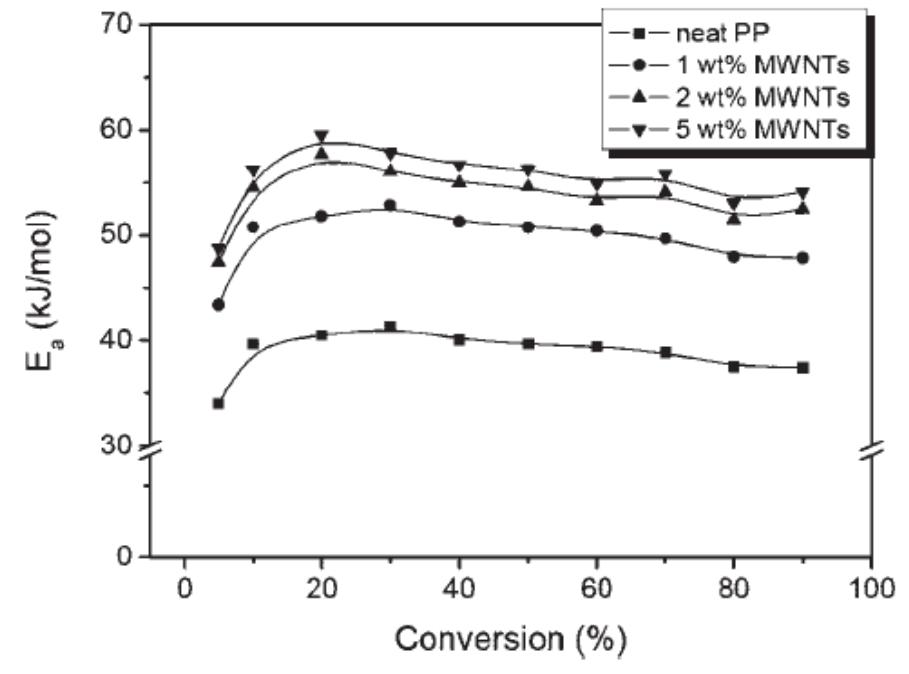
Figure 33. Activation energies for degradation (Ea) of different contents of MWCNTs- filled PP nanocomposites as a function of conversion using the Flynn-Wall-Ozawa method. Reproduced with permission from ref.